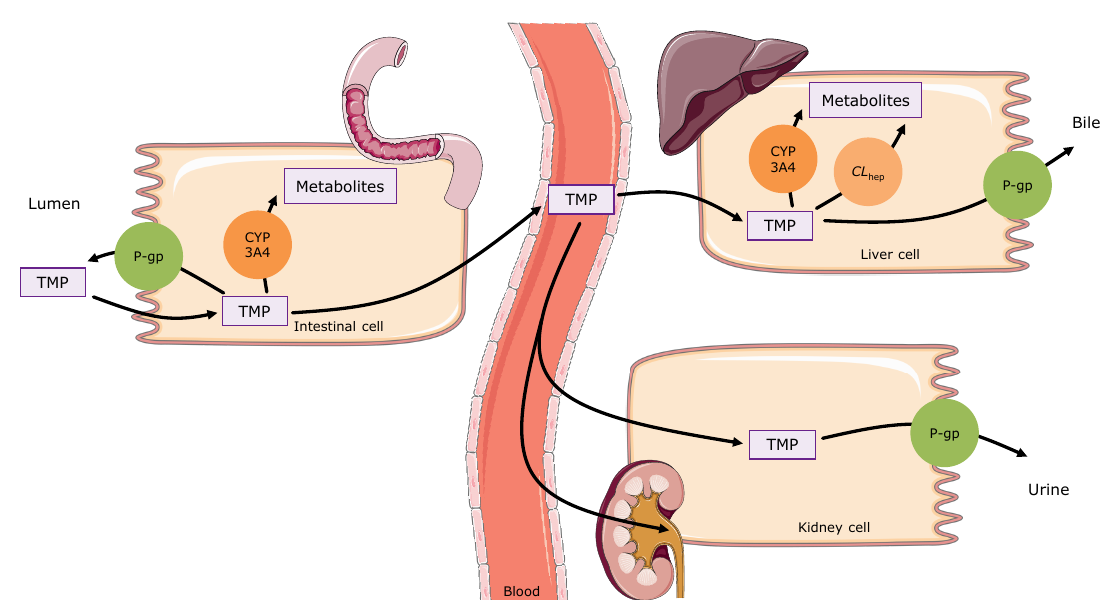
Figure 1. Schematic illustration of the trimethoprim absorption, distribution, metabolism, and excretion (ADME) processes in the model. Trimethoprim is absorbed in the intestine with counteractive e ffl ux via P-gp. About 20% of a trimethoprim dose is metabolized [33] (modeled via CYP3A4 and an additional CL hep ). The main route of trimethoprim elimination is urinary excretion (46–67% of an oral dose [30–32]) via glomerular filtration and active tubular secretion via P-gp. Drawings by Servier, licensed under CC BY 3.0 [34]. CL hep : hepatic metabolic clearance, CYP: cytochrome P450, P-gp: P-glycoprotein, TMP: